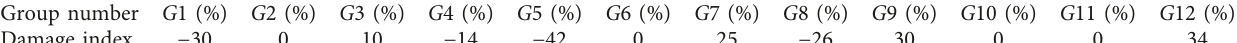
Table 5: Assumed damage level of the elastic modulus of the benchmark beam.